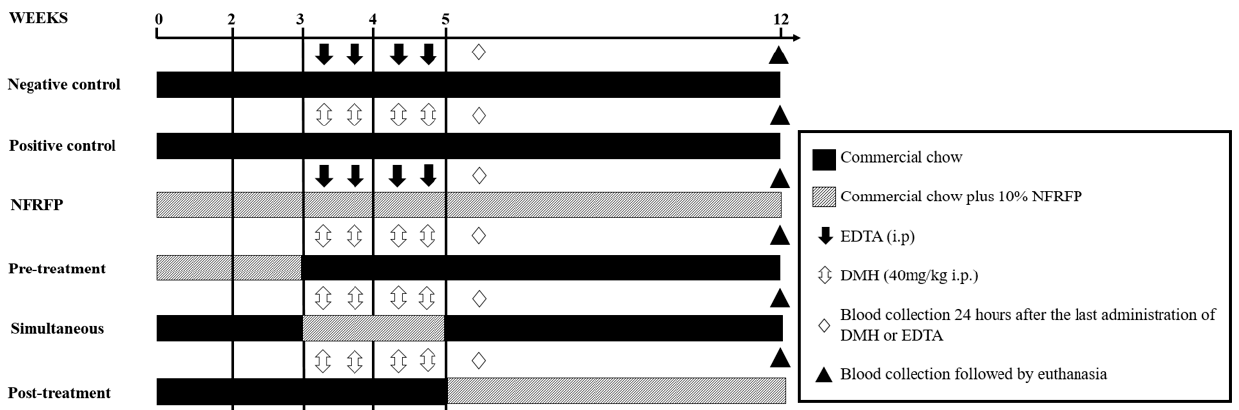
Figure 1. Experimental design. NFRFP—Natural Food Product Rich in Fiber; EDTA—ethylenedia-mine tetra-acetic acid; DMH—1,2-dimethylhydrazine; i.p.—intraperitoneal.